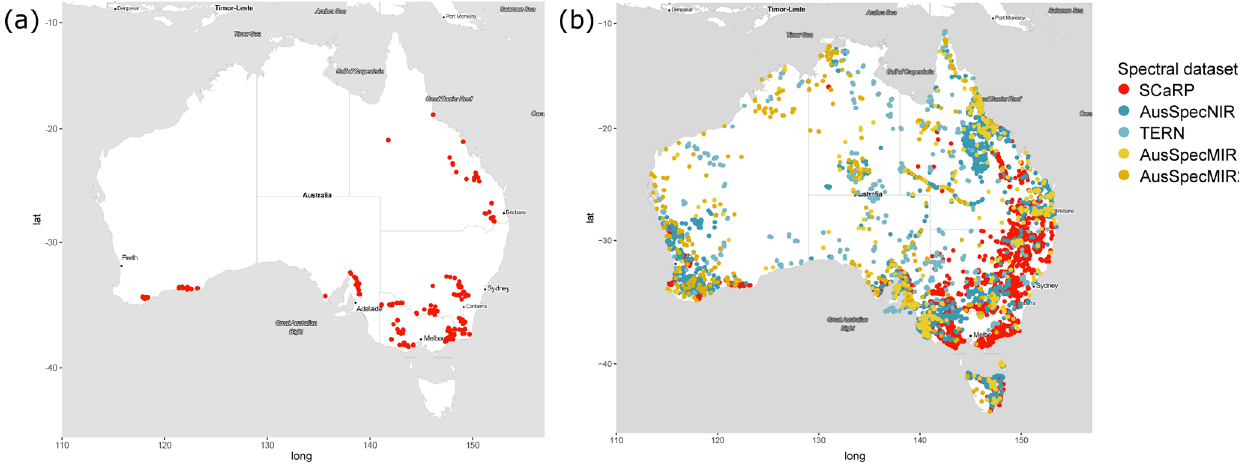
Figure 1. (a) Location of SCaRP soil samples subject to fractionation ( n = 312) by Baldock et al. (2013c). (b) Soil spectral datasets combined for mapping soil organic carbon fractions. TERN samples are part of the AusSpecNIR